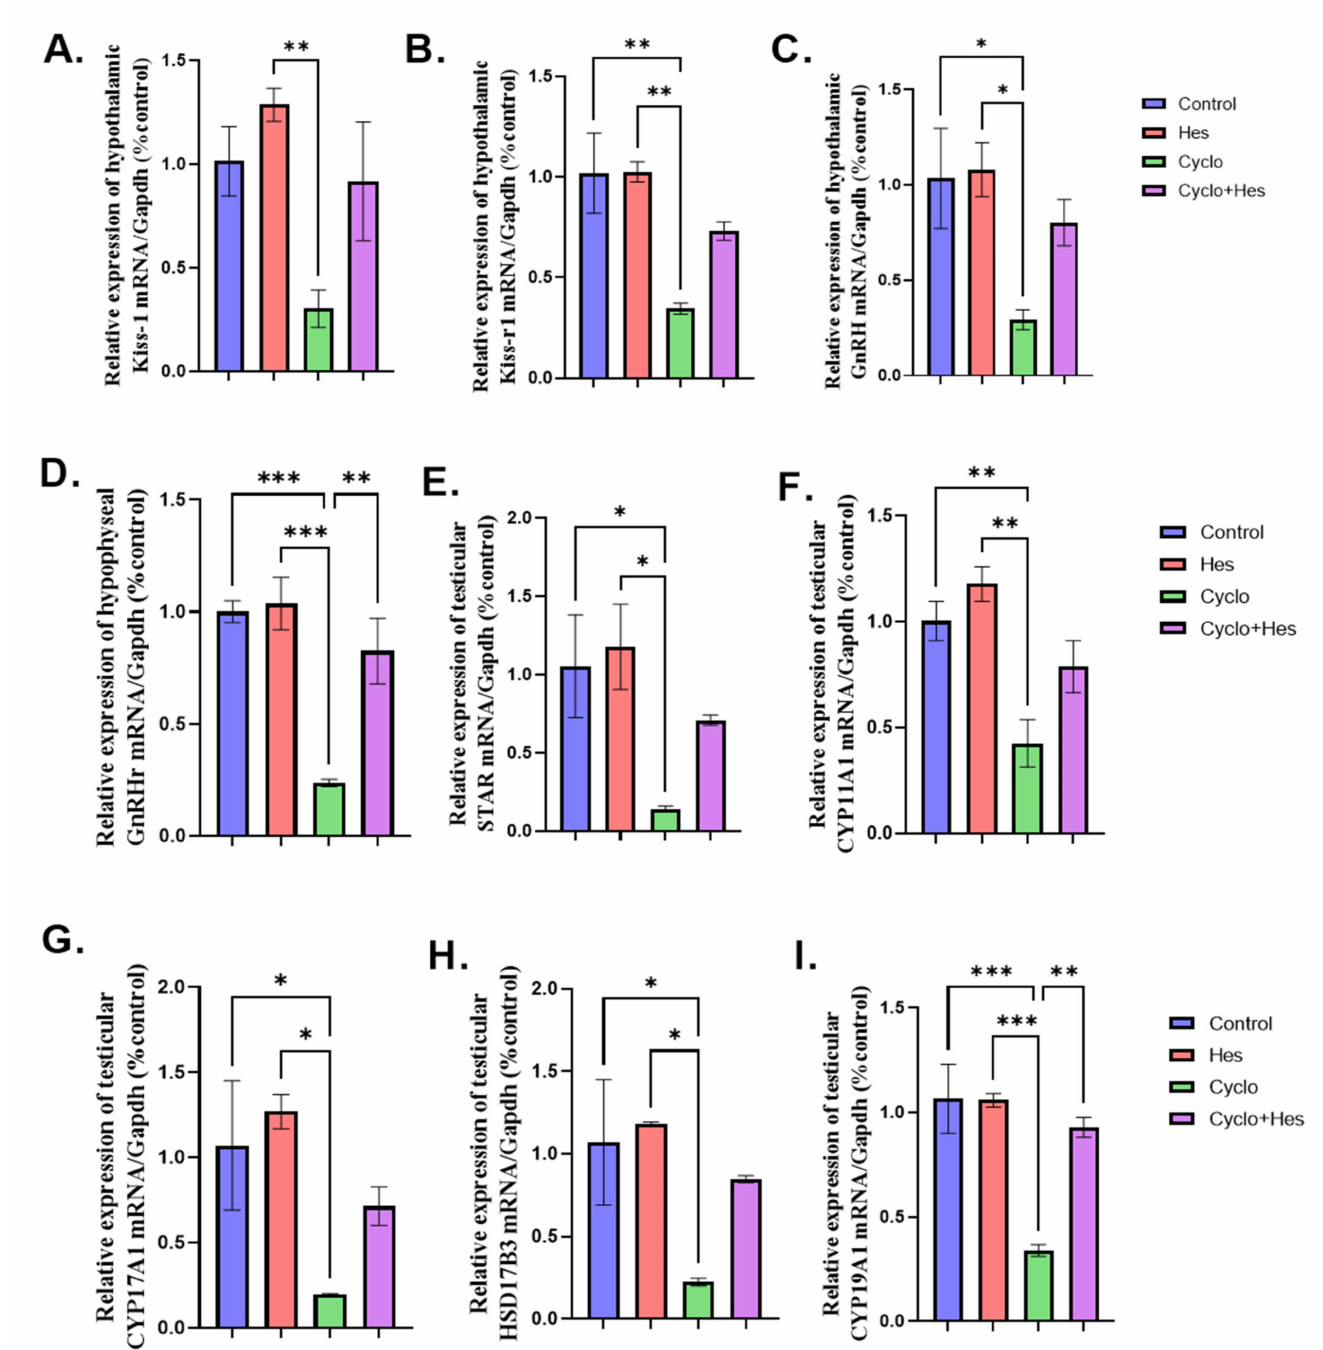
Figure 5. Effect of hesperidin administration in cyclophosphamide-induced testicular impairment in male rats on mRNA expression of hypothalamic KISS-1, KISS-1r, GnRH, hypophyseal GnRHr and testicular steroidogenic enzymes ( A – I ). ( A ) Hypothalamic KISS-1/Gapdh (% control), ( B ) mRNA expression of hypothalamic KISS-1r/Gapdh (% control), ( C ) mRNA expression of hypothalamic GnRH/Gapdh (% control), ( D ) mRNA expression of hypophyseal GnRHr/Gapdh (% control), ( E ) Testicular Star/Gapdh (% control), ( F ) Testicular Cyp11a1/Gapdh (% control), ( G ) Testicu- lar Cyp17A1/Gapdh (% control), ( H ) Testicular HSD17B3/Gapdh (% control), and ( I ) Testicular Cyp19A1/Gapdh (% control). Data are expressed as means ± SEM. *, **, *** indicate significant difference ( p <